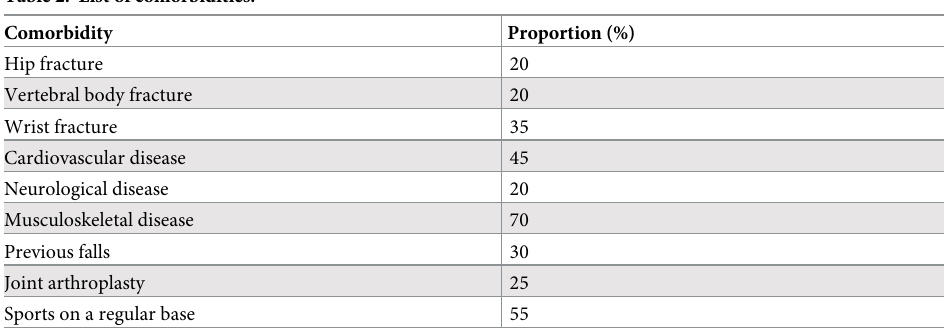
Table 2. List of comorbidities.